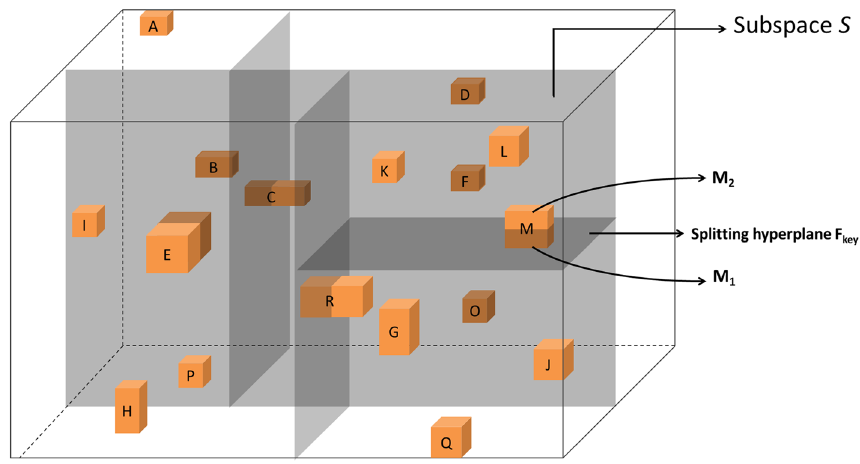
Fig. 3 Dividing instances in 3D space. In the figure3, the largest cube represents space D, and each orange cuberepresents a cluster cell. The gray planes represent splitting hyperplanes be‑tween different subspaces